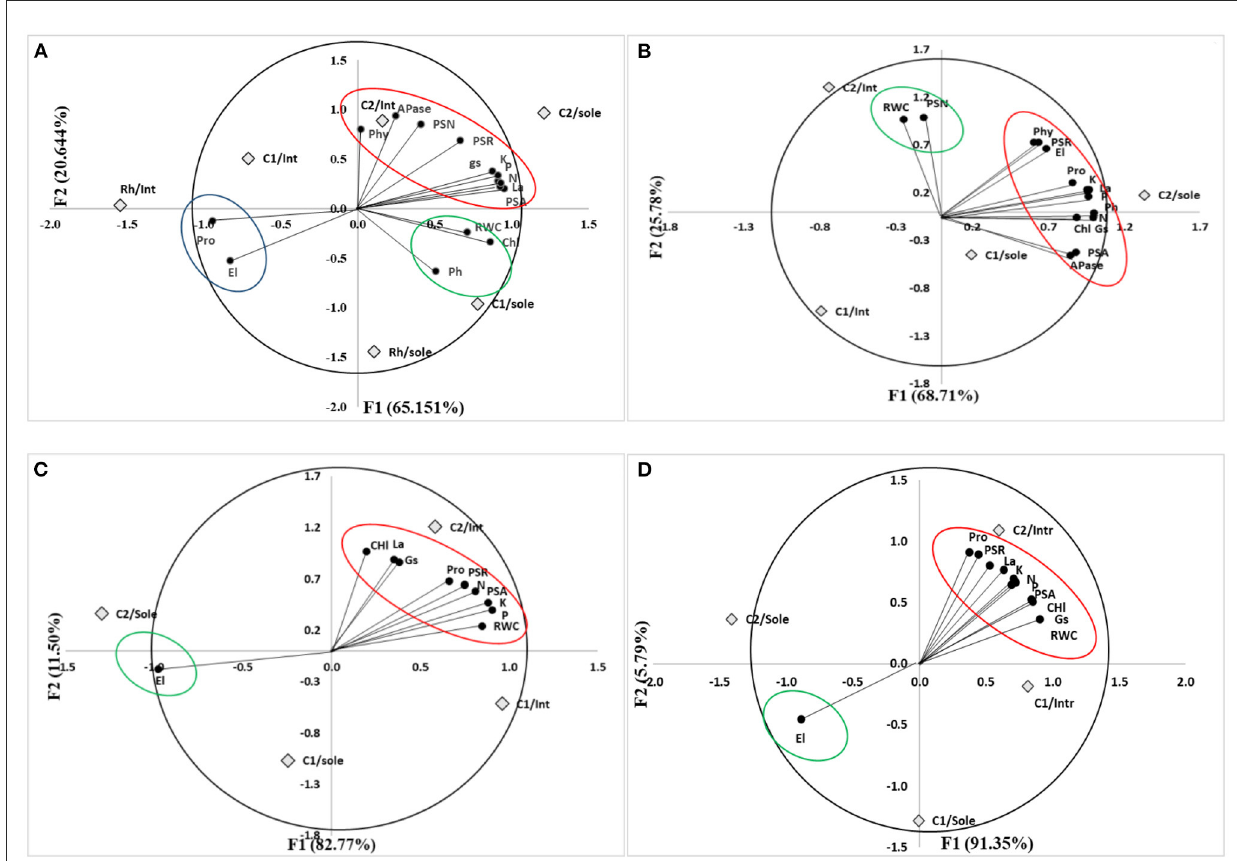
FIGURE11 Principal component analyses (PCA) of faba bean inoculated with C1 and C2 under P limitation (A) and under water deficit and P limitation (B) and wheat inoculated with C1 and C2 under P limitation (C) and under water deficit and P limitation (D) . Faba bean sole-cropped (Sole): inoculated with rhizobia only; Rh. Faba bean intercropped (Int): Int, wheat sole-cropped; (Sole). wheat intercropped; (Int). PSA, shoot dry weight; PSR, root dry weight; PSN, nodule dry weight; gs, stomatal conductance; La, leaf area; RWC, relative water content; EL, electrolyte leakage; Ph, leaf water potential; Pro, proline content; aPase, phosphatase activity, Phyt, phytase activity; N, nitrogen content, K + , potassium content; P, phosphorus